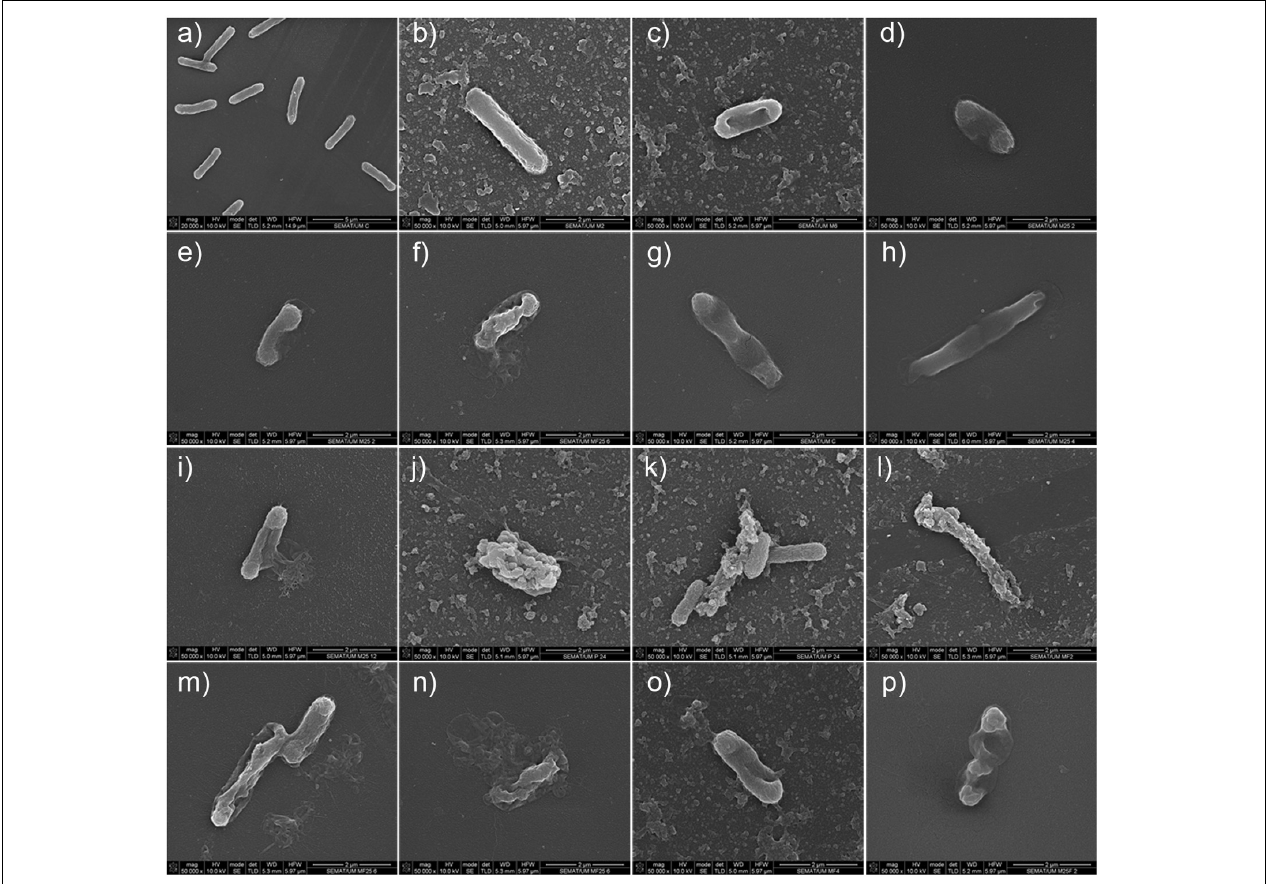
FIGURE 5 | SEM micrographs showing the effect of honey, phage, and honey–phage combination treatments in E. coli cells. (a) Control E. coli , (b–i) honey treatment, (j,k) phage treatment, (l–p) phage–honey treatment. The honey used in these experiments was